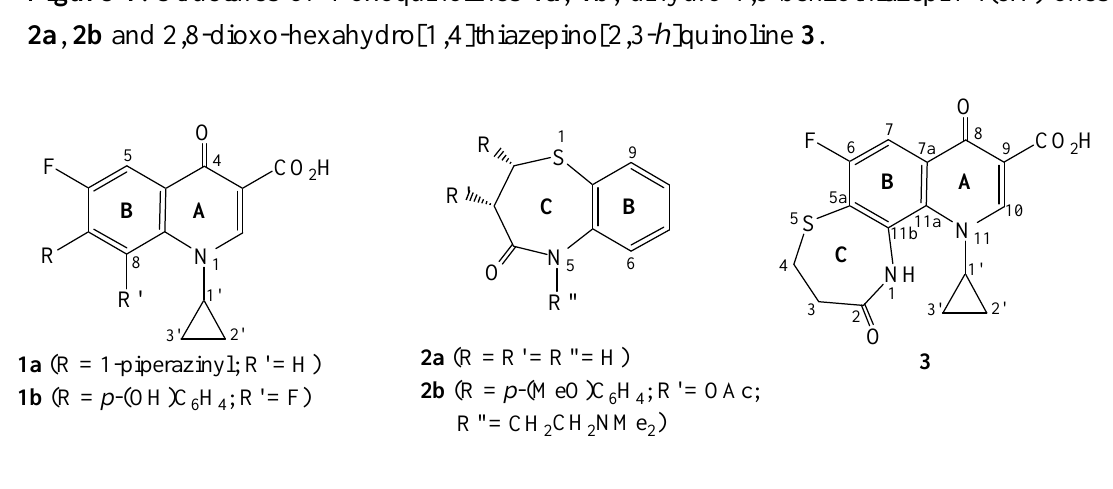
Figure 1 . Structures of 4-oxoquinolines 1a , 1b , dihydro-1,5-benzothiazepin-4(5 H )-ones 2a , 2b and 2,8-dioxo-hexahydro[1,4]thiazepino[2,3- h ]quinoline 3